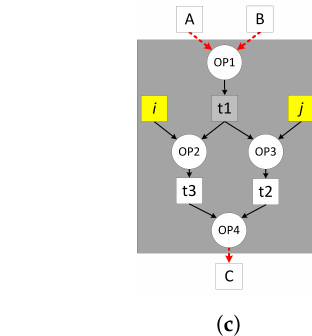
Figure 5. A range of dataflow models taken from [24,25]. ( a ) DFG node without internal storage